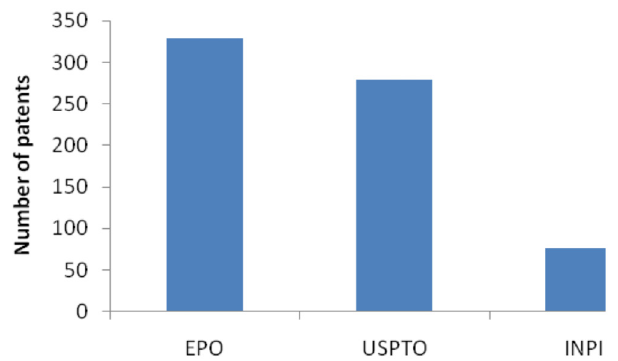
FIGURE 1 - Number of patents on herbal extracts applied in cosmetic area deposited in EPO, USPTO and INPI